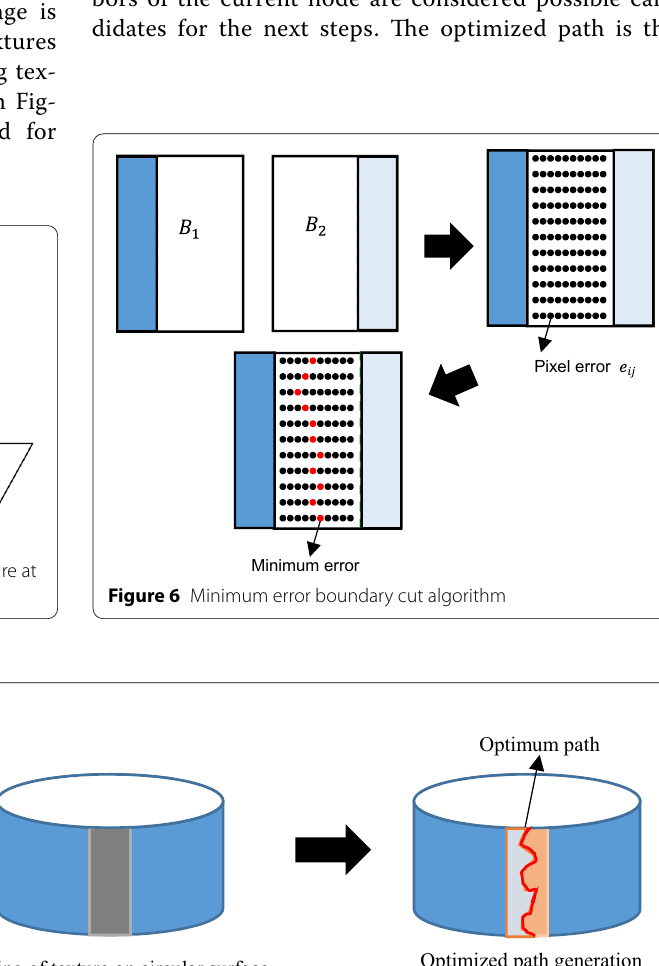
Generation of texture in 2D image Mapping of texture on circular surface Optimized path generation Figure 5 Modified texture generation for closed geometries